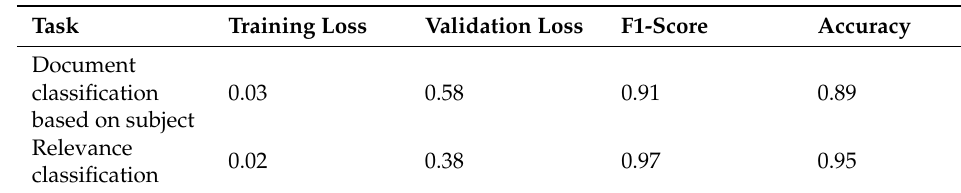
Table 6. Fine-tuning results of documents classification.